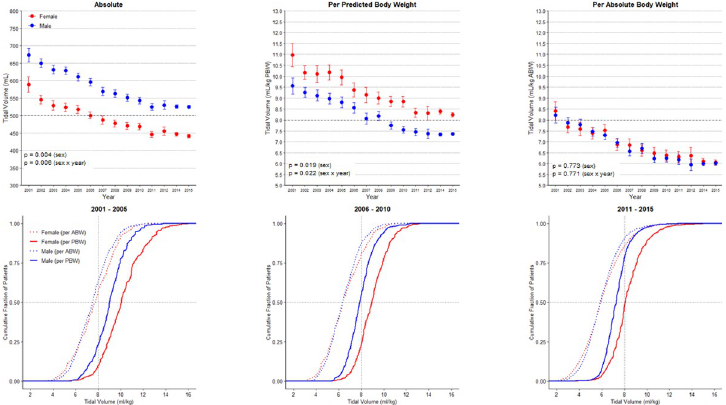
Fig 1. Absolute tidal volume and corrected tidal volume (by predicted body weight or absolute body weight) over years and according to tertiles of year. PBW: predicted body weight; ABW: actual body weight. p values for the sex reflect the overall test for difference between sex over the years while p values for the sex x year interaction evaluate if change over time differed by sex. There is no interaction between dataset and sex ( p = 0.311, p = 0.100, p = 0.483 for absolute, corrected by PBW or ABW, respectively), or dataset and sex x year interaction ( p = 0.310, p = 0.100, p = 0.482 for absolute, corrected by PBW or ABW,